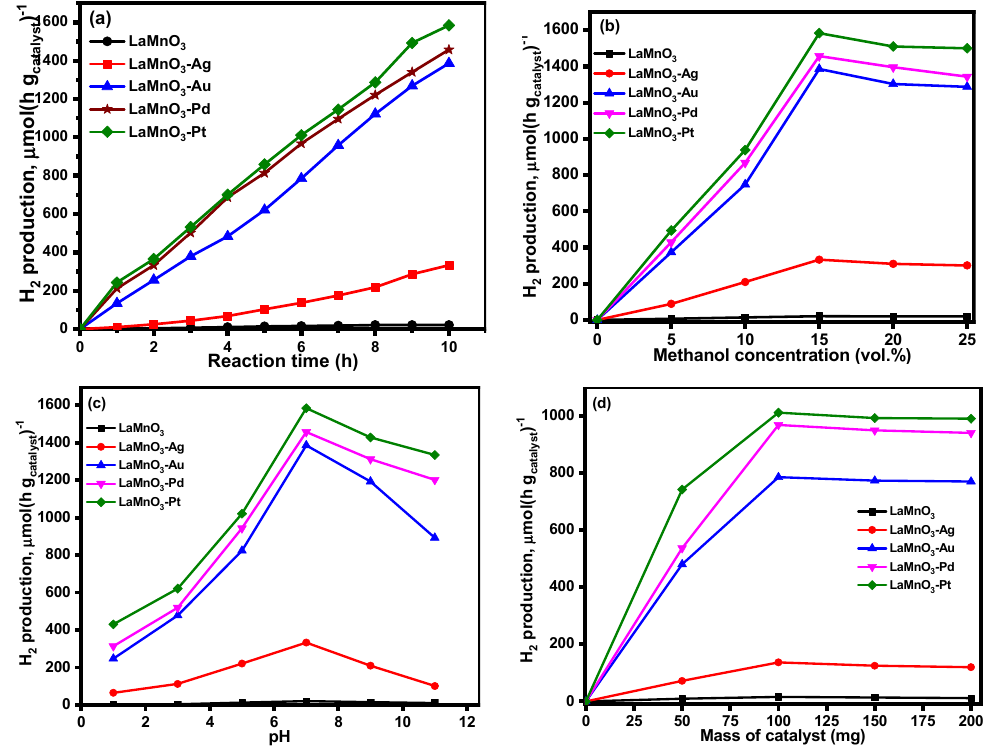
Figure 9. Photocatalytic H 2 production, influence of ( a ) reaction time, ( b ) methanol concentration, ( c ) pH, and ( d ) mass of catalyst.